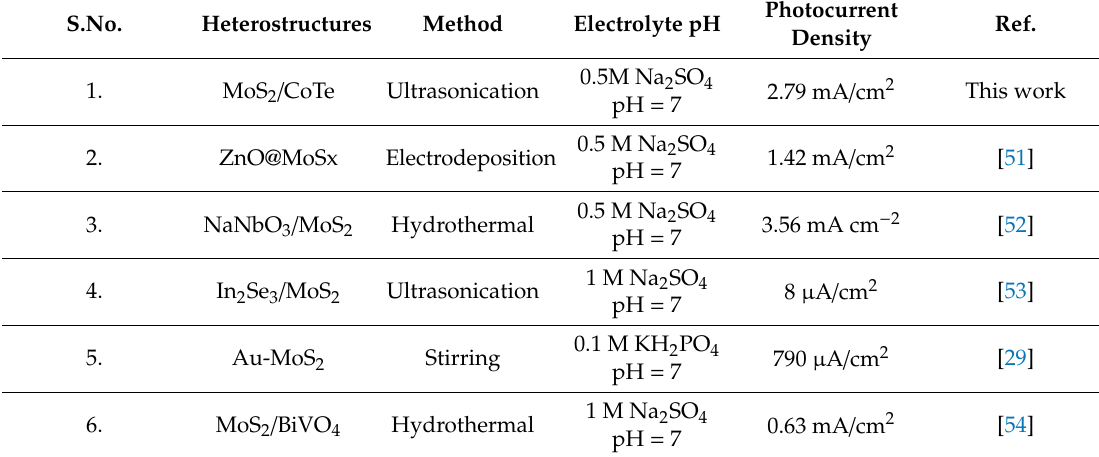
Table 1. A comparison of reported MoS 2 -based photoanodes with the current